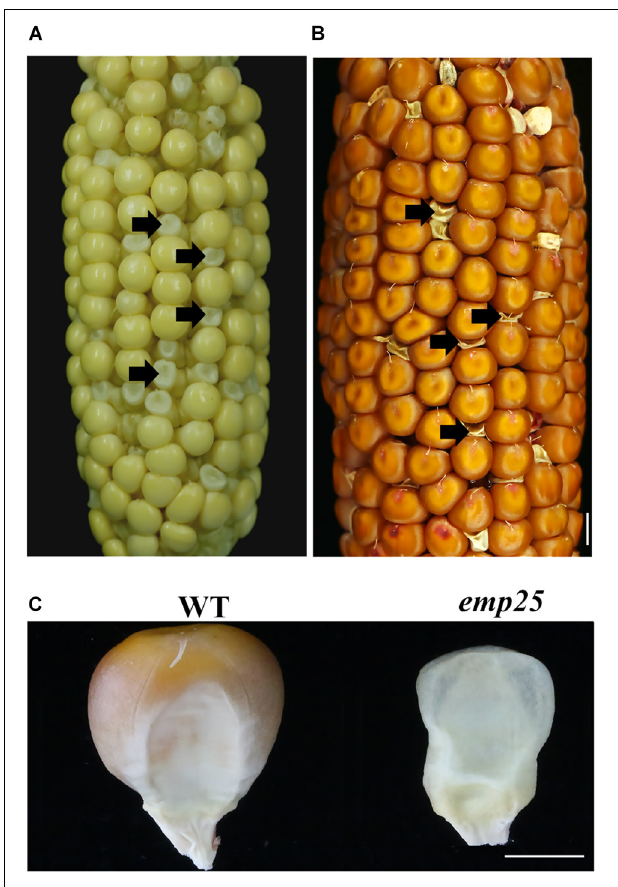
FIGURE 1 | Phenotype of emp25. (A,B) The ear segregates the emp25 kernels at 11 days after polination (DAP) (A) and maturity (B) . Arrows indicate the mutants. Scale bar = 0.5 cm. (C) Germinal side view of the WT and emp25 kernel. Scale bar = 0.2 cm.